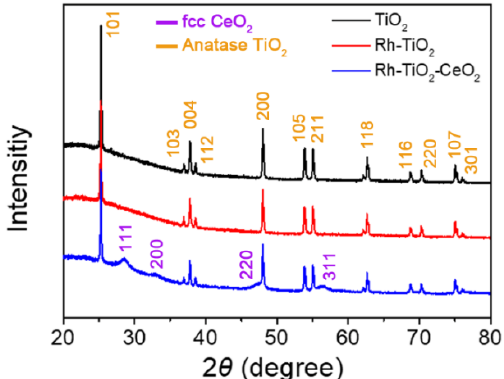
Figure 1. XRD patterns of the Rh–TiO 2 –CeO 2 hybrid, Rh–TiO 2 hybrid, and TiO 2 photocatalysts.